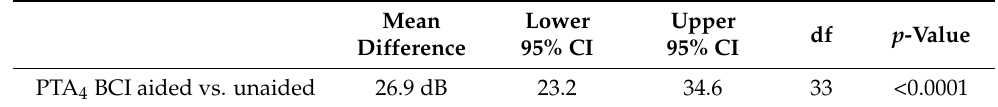
Table 3. Functional gain.